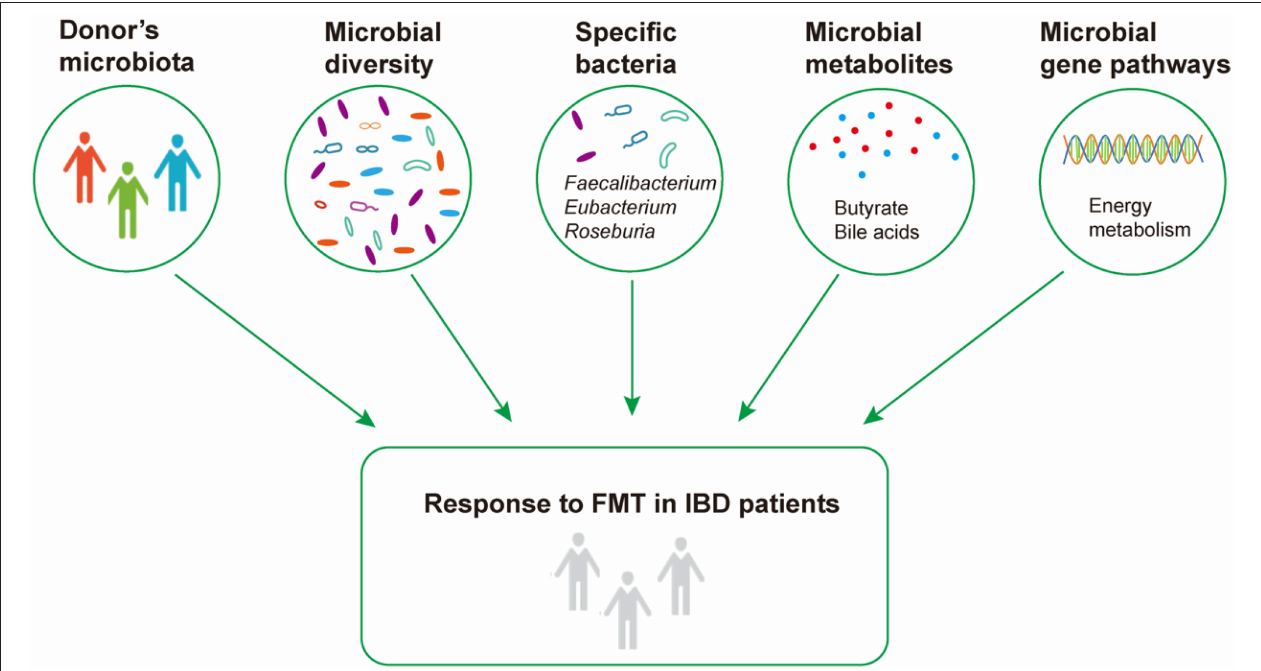
FIGURE 2 | Microbial factors influencing response to fecal microbiota transplantation in inflammatory bowel